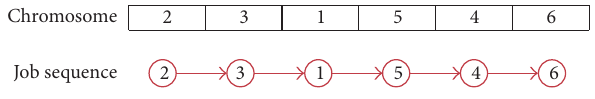
Figure 2: Representation of